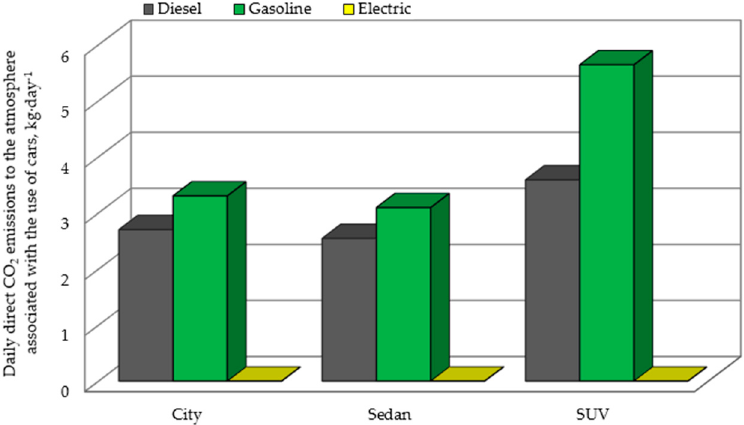
Figure 3. Daily direct CO 2 emissions to the atmosphere associated with the use of a car in the city (distance of 26 km) divided into City, Sedan, and SUV classes.